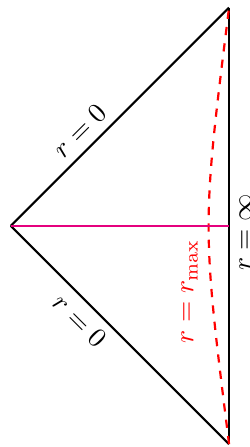
Figure 20 . Penrose diagram of the vacuum whose metric is given in eq. (2.13). The red dashed curve is the radial cutoff at r = r . Moreover, the magenta straight line denotes the extremal max hypersurface anchored at t = 0 which is applied in the calculation of the complexity of